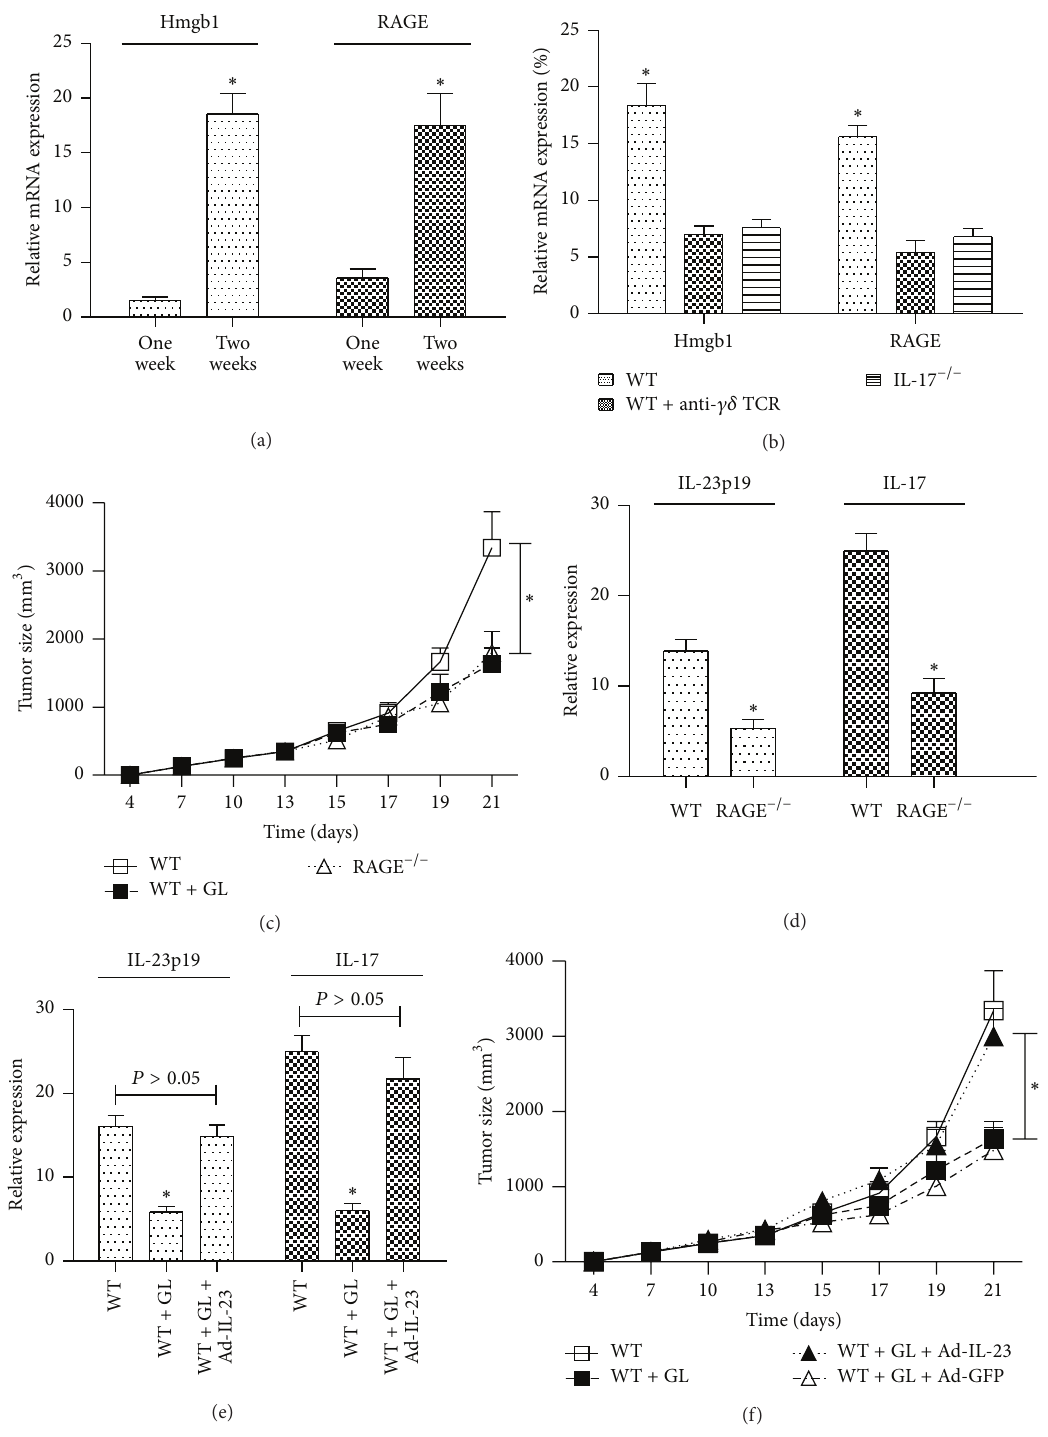
Figure 4: The Hmgb1-RAGE pathway mediates the production of IL-23. (a) mRNA levels of Hmgb1 and RAGE were analyzed by realtime PCR in tumor tissues from tumor-bearing mice one or two weeks after B16-F10 inoculation ( 𝑛 = 5 ). (b) Hmgb1 and RAGE mRNA levels were analyzed by realtime PCR in tumor tissues two weeks after B16-F10 inoculation from WT, WT + anti- 𝛾𝛿 TCR, and IL-17 −/− groups ( 𝑛 = 5 ). (c) Tumor growth in B16 tumor-bearing wild-type mice treated i.p. with 10mg/mouse glycyrrhizin (GL) on days 0, 2, 5, 10, and 15 and B16 tumor-bearing RAGE −/− mice ( 𝑛 = 5 ). (d) IL-23p19 and IL-17 relative mRNA expression in tumor tissues from B16-F10 tumor-bearing wild-type mice and RAGE −/− mice ( 𝑛 = 5 ). (e) IL-23p19 and IL-17 relative mRNA expression in tumor tissues from B16-F10 tumor-bearing wild-type mice treated with GL or GL + Ad-IL-23 or left untreated ( 𝑛 = 5 ). (f) Tumor growth in B16 tumor-bearing wild-type mice treated with GL, or GL + Ad-IL-23, GL + Ad-GFP or left untreated ( 𝑛 = 5 ). The data show means ± SEM of tumor size and are representative of three independent experiments. ∗ 𝑃 < 0.05